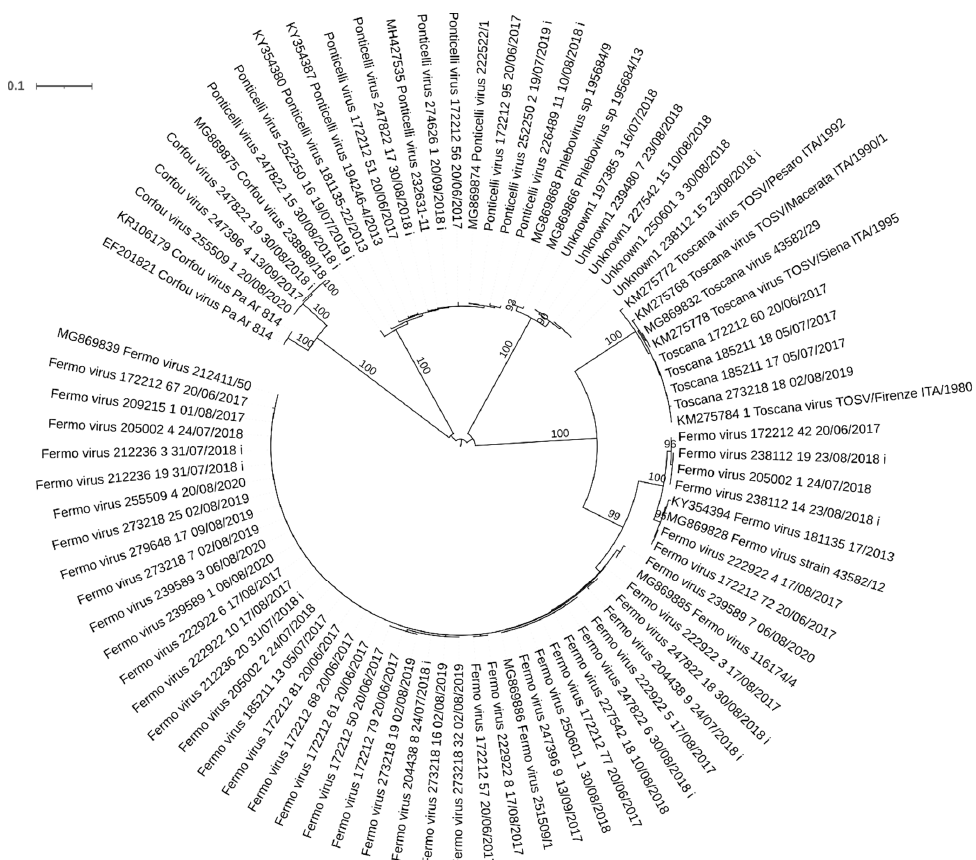
Table 3. Results of the analysis of the sand fly pools (25 specimens) with successful isolation.